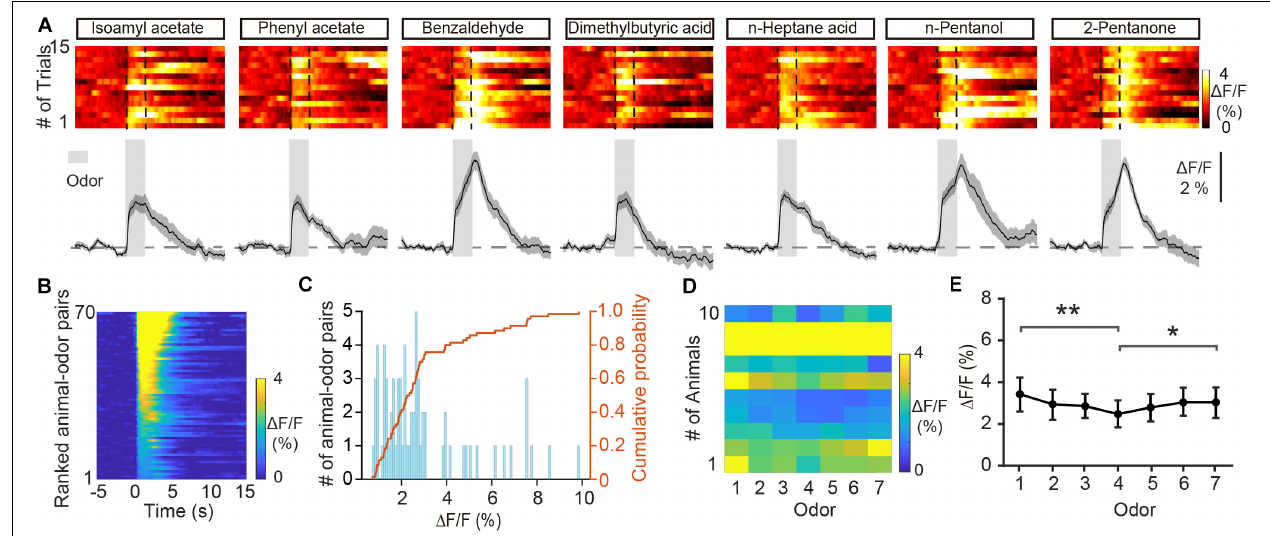
FIGURE 2 | Odor-evoked responses in GCs of the OB are excitatory. (A) Trial-to-trial pseudocolored heat maps (top) and trial-averaged traces (bottom) of the calcium responses evoked by different odors. (B) Heat maps of (cid:49) F/F averaged across all trials and further averaged across odorants for each mouse, ranked by mean (cid:49) F/F. (C) Histograms and cumulative probability of (cid:49) F/F. (D,E) Pseudo-color heat-map of (cid:49) F/F (D) and averaged (cid:49) F/F (E) evoked by different odors. [Friedman test: χ 2 (6, 54) = 18.8, P = 0.0046, odor 1 versus odor 4, P = 0.00106, odor 4 versus odor 7, P = 0.0428]. * P < 0.05, ** P <